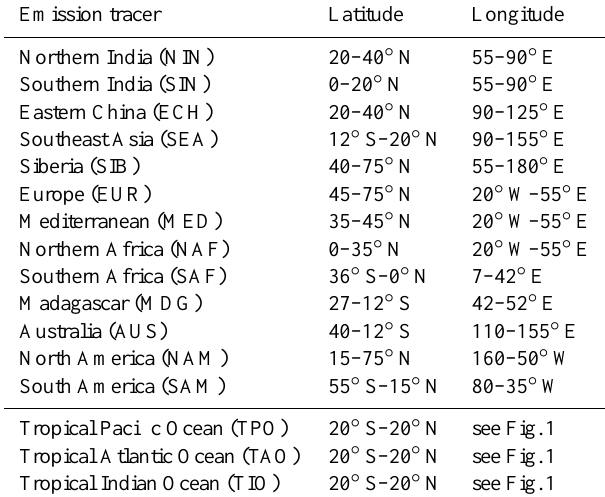
Table 1. Latitude and longitude range of artificial boundary layer sources in the CLaMS model, also referred to as “emission tracers”. The geographic position of each emission tracer is shown in Fig.